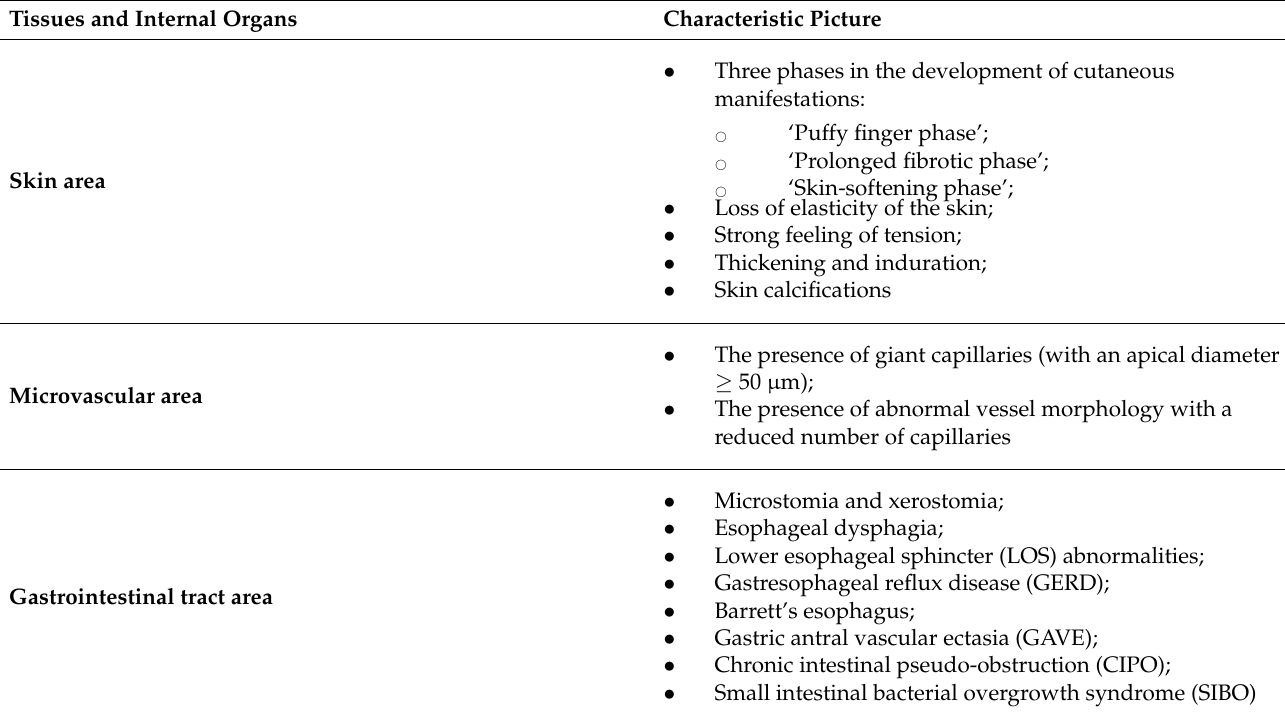
Table 2. The most characteristic images of SSc in various